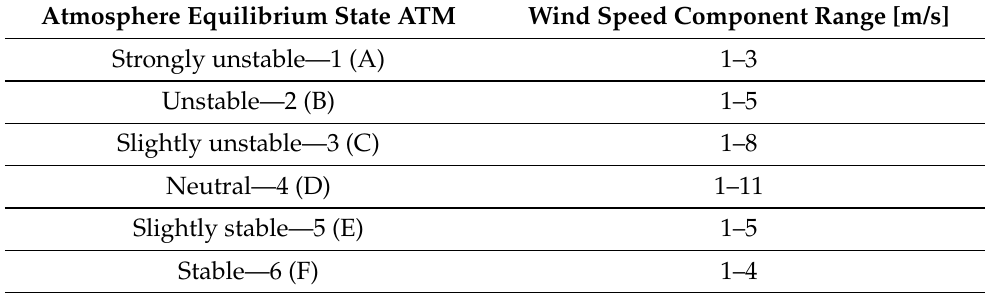
Table 1. Wind speed ranges assigned to atmospheric equilibrium states according to the classification of the IMWM